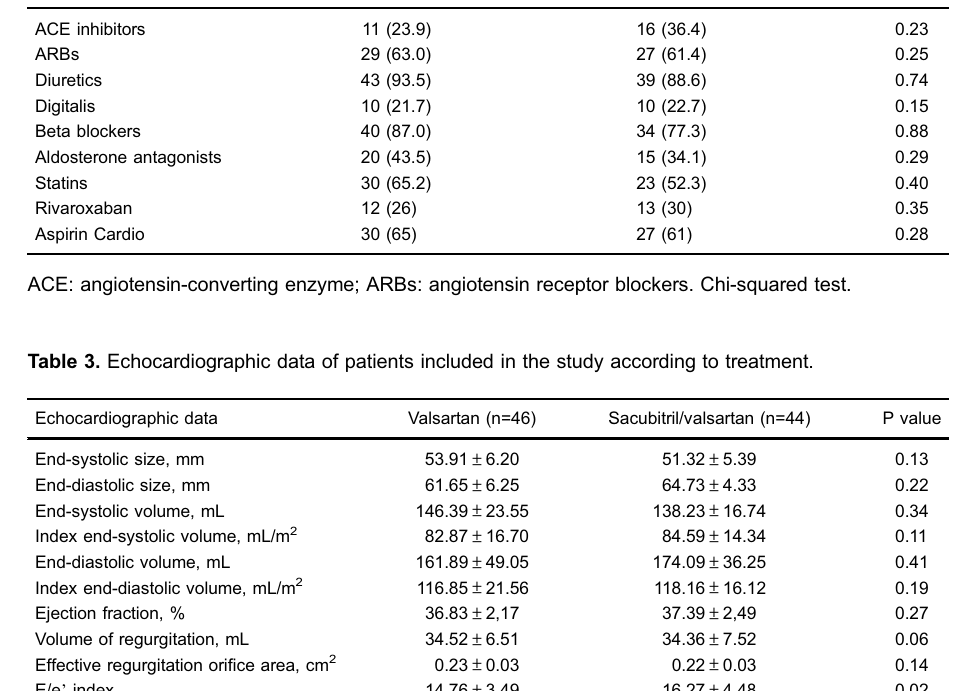
Table 2. Drug therapy of patients prior to enrollment in the study according to treatment. Primary therapy, n (%)